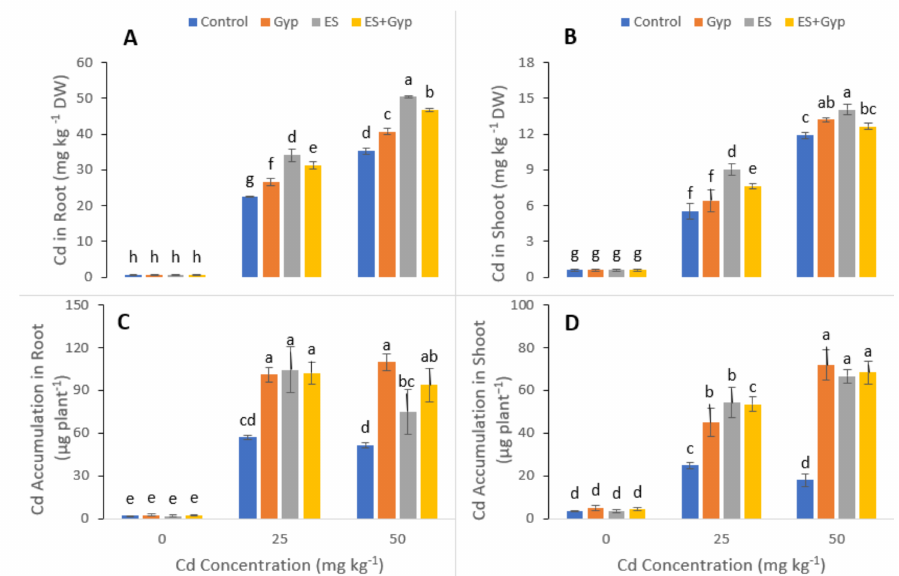
Figure 6. Effect of different concentrations of Cd (25, 50 mg kg − 1 ) in the soil on Cd uptake and accu- mulation i.e., Cd concentration in the shoots ( A ), Cd concentration in the roots ( B ), Cd accumulation in the shoots ( C ) and Cd accumulation in the roots ( D ) of S. nigrum grown under the S-fertilizers, alone with GYP, and ES and in combination with GYP+ES . S-fertilizer showed a significant increase in growth parameters compared to control. Bars sharing different letter(s) for each parameter are significantly different from each other according to Duncan’s multiple range test ( p < 0.05). All the data represented are the average of four